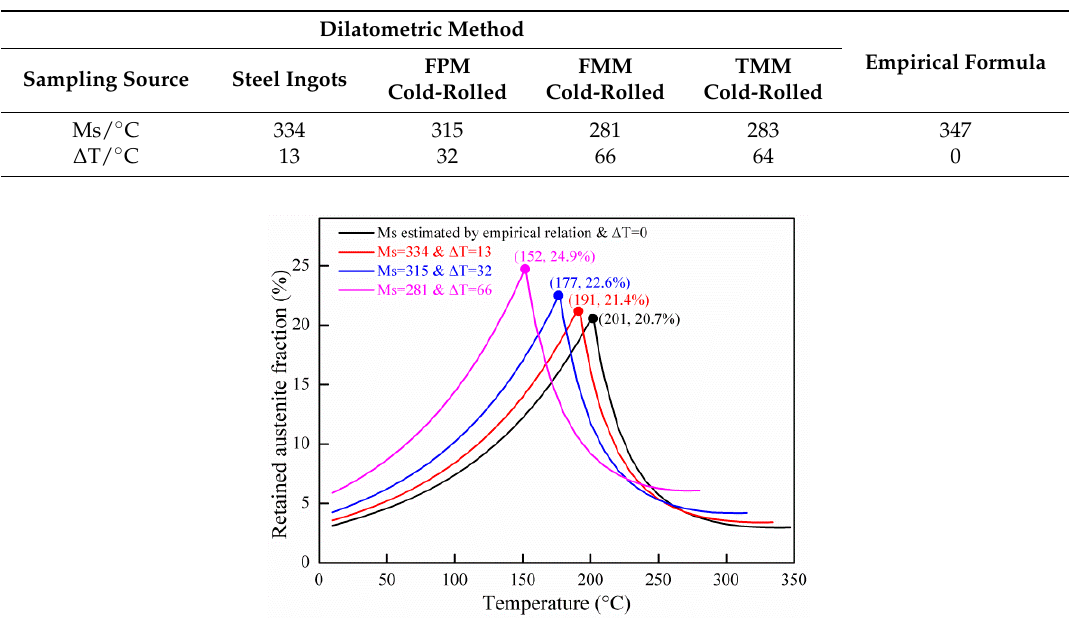
Figure 10. Theoretical calculation of the optimum quenching temperature influenced by different Ms temperatures.